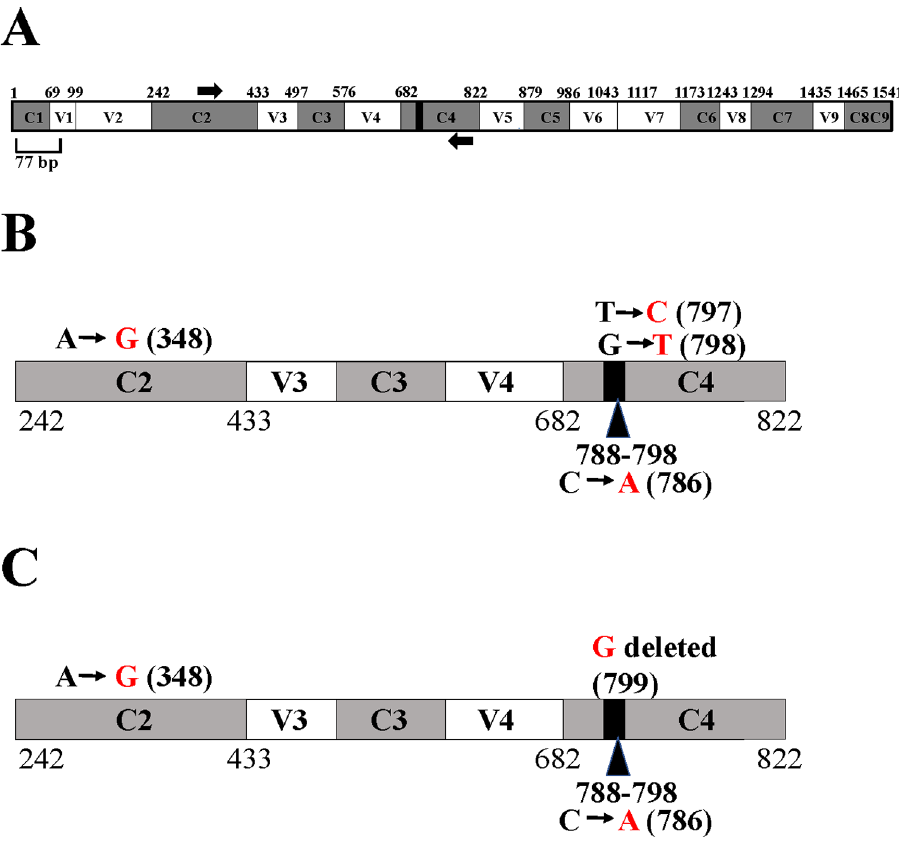
Figure 10. PCR amplification of the partial 16S rRNA gene of Clip185 and NCBI-BLAST analyses. (A) A schematic diagram showing the nine conserved and hypervariable regions in the 16S rRNA gene. The interspersed conserved regions (C1 – C9) are shown in dark gray, and the hypervariable regions (V1 – V9) are depicted in white. The black box within the C4 region represents 11 nucleotides (788-798 base pairs) that are invariant in bacteria. 8,9 Thick black arrows denote 16S rRNA gene-specific forward and reverse PCR primers in the C2 region and in the C4 region, respectively. The gene diagram is based on the 16S rRNA gene sequence of E. coli. See also Underlying data. 42 (B) A schematic diagram showing the nucleotide changes in Clip185 in the 16S rRNA region spanning the C2 and C4 regions in comparison to the best NCBI- BLAST hit in 2019 (score of 800; E-value 0 and percent identity of 99.10%): Microbacterium binotii strain PK1-12M 16S ribosomal RNA gene, partial sequence (GenBank Accession #: MN428150.1). (C) A schematic diagram showing the nucleotide changes in Clip185 in the 16S rRNA region spanning the C2 and C4 regions in comparison to the best NCBI- BLAST hit in 2021 (score of 806; E-value 0 and percent identity of 99.33%): Microbacterium sp. strain MDP6 16S ribosomal RNA gene, partial sequence (GenBank Accession #: MK128451.1). Black nucleotides show the native nucleotides in the BLAST hits Microbacterium binotii strain PK1-12M and Microbacterium sp. strain MDP6 that were substituted by the depicted red nucleotides in Clip185 16S rRNA gene sequence. The black bold numbers within the parenthesis beside the nucleotides show the specific nucleotide positions where the nucleotide changes have occurred. Nucleotide positions shown in the figures have been assigned according to that of the 16S rRNA gene sequence of E.